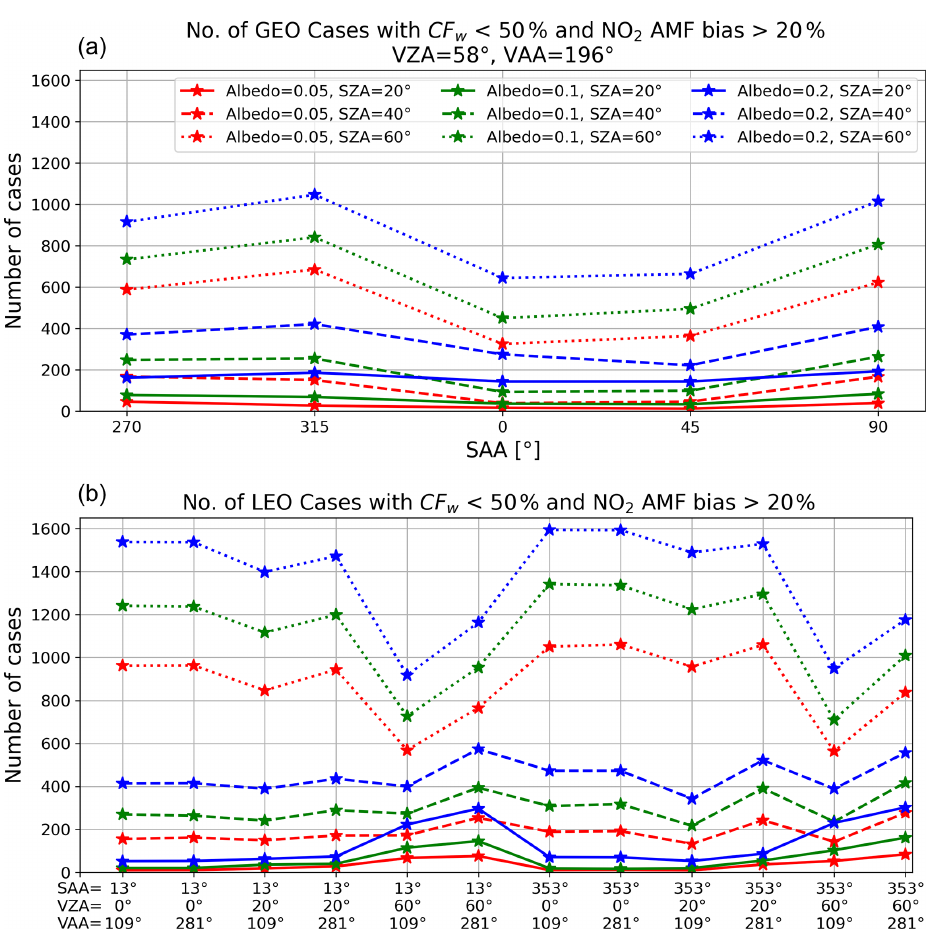
Figure 5. Number of pixels with weighted radiometric cloud fraction CF w < 50% and NO 2 AMF bias > 20% for geostationary (a) and low-earth-orbiting (b) geometries. The data points are connected by lines for increased readability. Different line styles indicate different SZAs, while line colours are used for the surface albedo as given in the annotation. For the geostationary geometry, the solar azimuth angle (SAA) for each case is given on the x -axis label, while for the low-earth-orbiting geometry, the viewing zenith angle (VZA) and viewing azimuth angle (VAA) are given in addition. The total number of pixels for a single case is